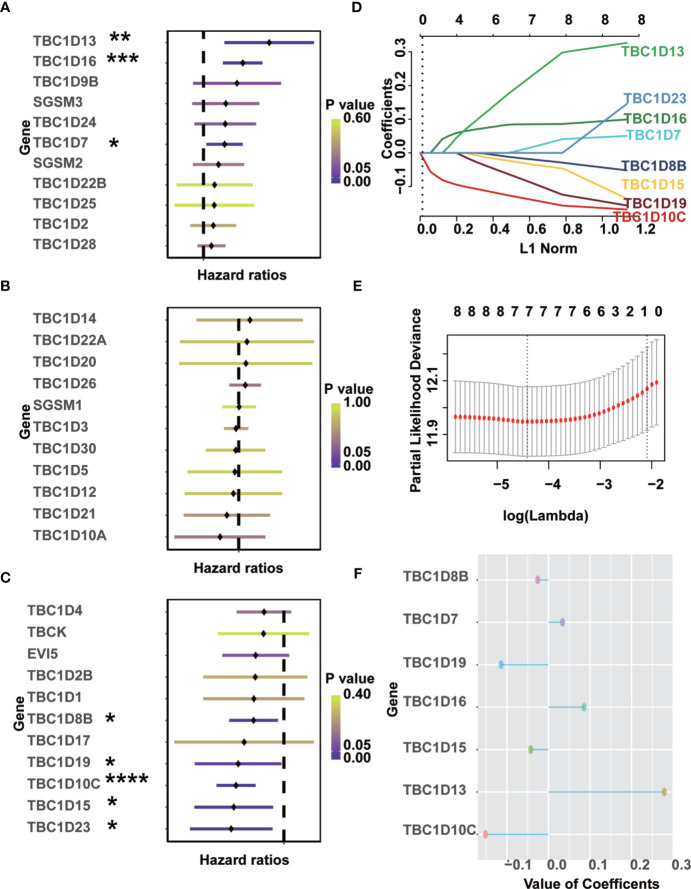
Identification of prognostic-associated TBCs from TCGA. (A–C) Univariate Cox regression analyses were finished to screen prognostic-associated TBCs from TCGA. (D–F) LASSO coefficients of the seven prognostic-associated TBCs were calculated and displayed. *p < 0.05, **p < 0.01, ***p < 0.001, **** < 0.0001.